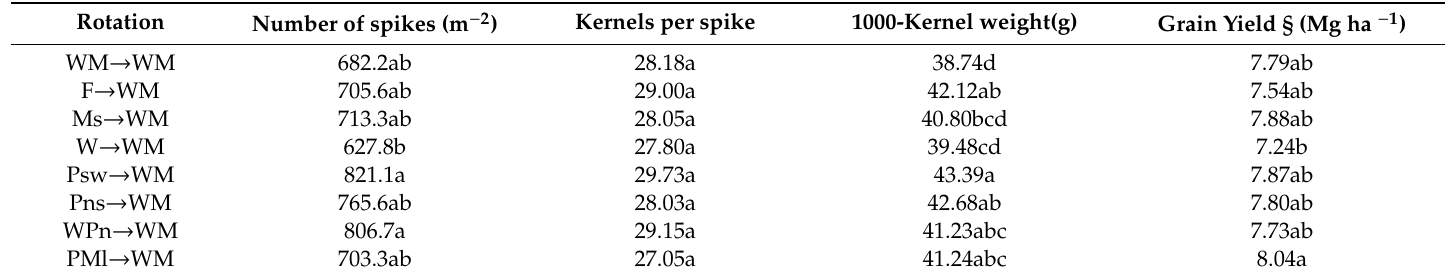
Table 3. Eight rotations e ff ect on yield components and grain yield of 2017 / 2018 winter